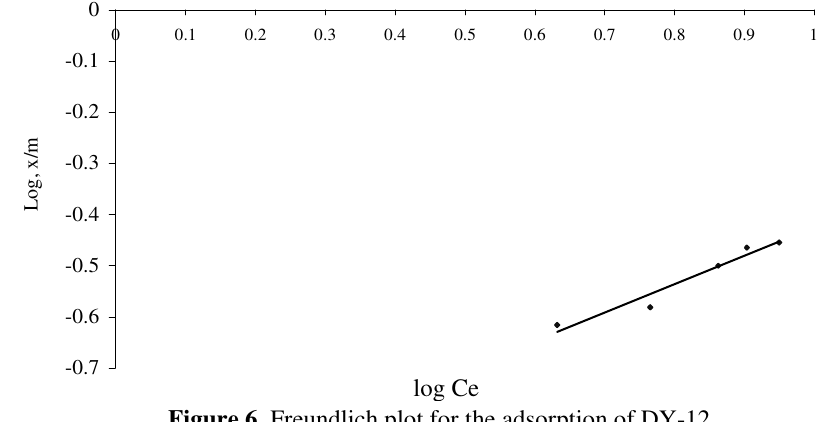
Figure 6. Freundlich plot for the adsorption of